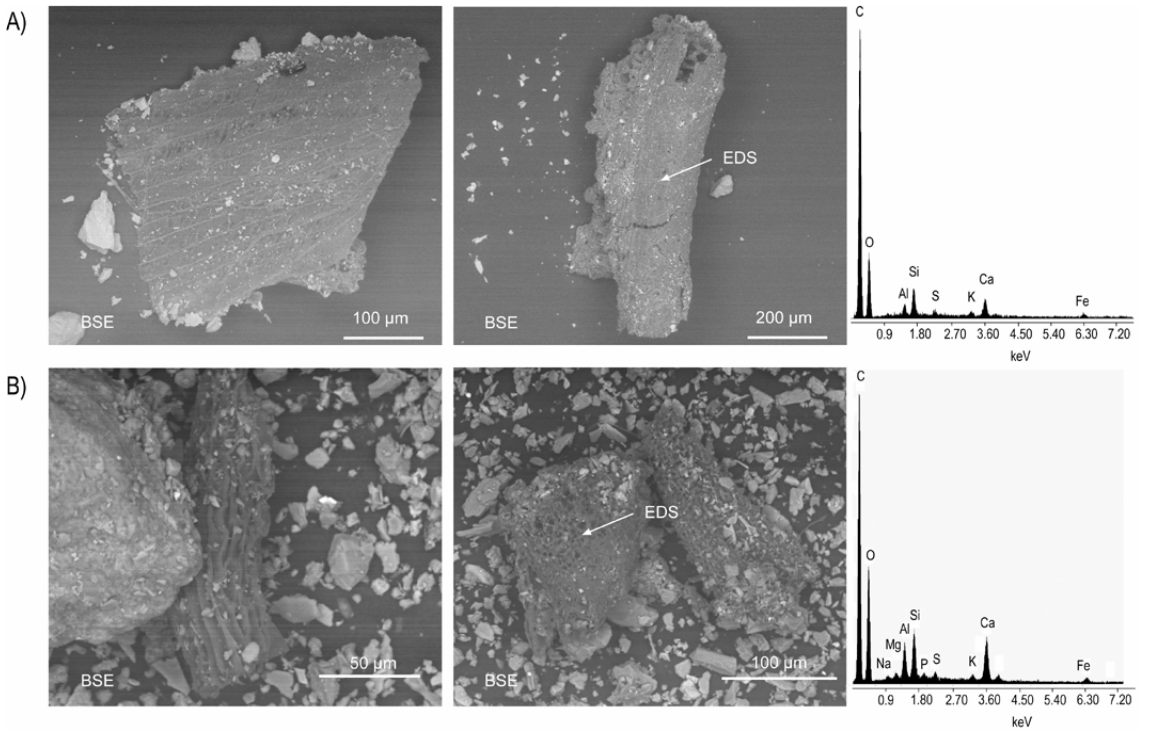
Fig. 6. Environmental scanning electron microscopy (ESEM) and energy-dispersive spectroscopy (EDS) on organic particles (charcoal) with a density < 1gcm − 3 . (A) Exposure age three years (sample AS29); (B) exposure age 20yr (sample AS24). BSE = back-scattered